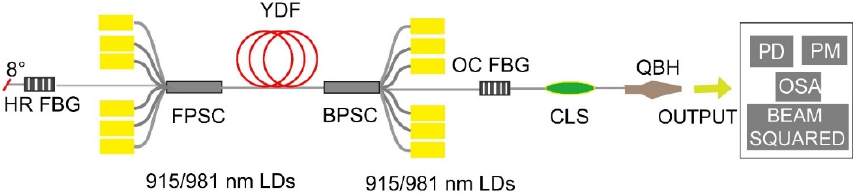
Figure 1. Schematic diagram of fiber laser oscillator (LD: laser diode, PSC: pump/signal combiner, CLS: cladding light stripper, HR FBG: high reflection fiber Bragg grating, OC FBG: output coupler fiber Bragg grating, YDF: ytterbium-doped fiber) .